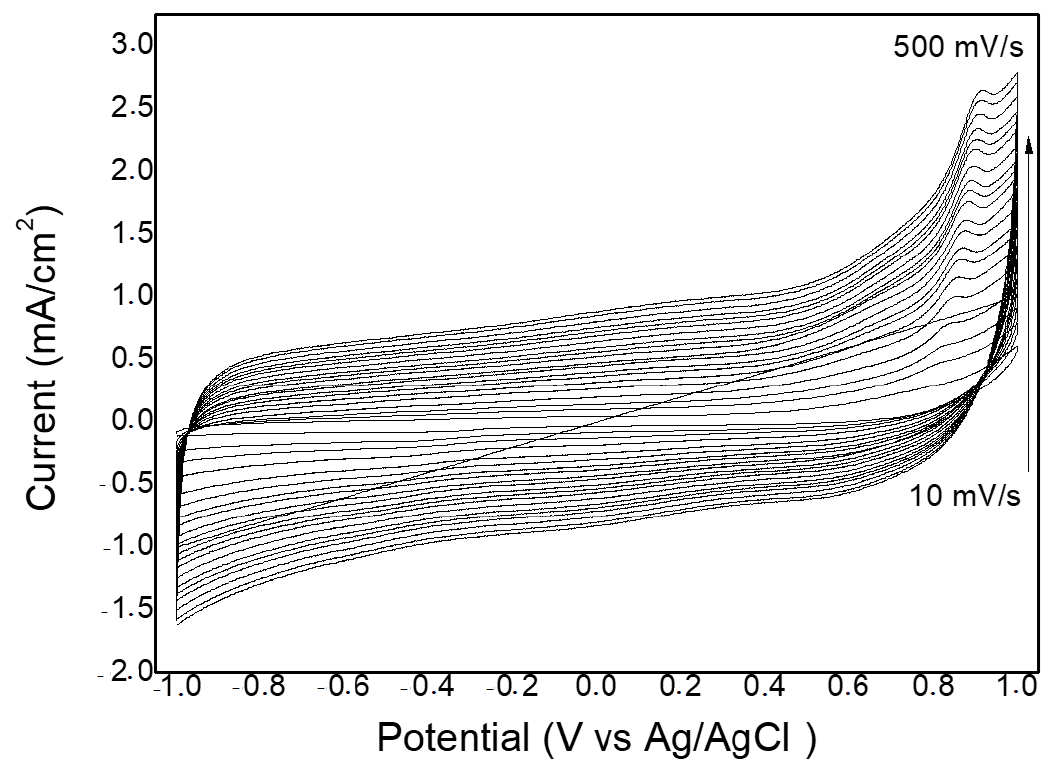
Figure 7. CV of Mo/CNT/GCE under different srs (10, 30, 50, 100, 120, 150, 180, 200, 230, 250 300, 320, 350, 380, 400, 420, 450, 480, 500 mV · s − 1 ) in 5 mM L-C.